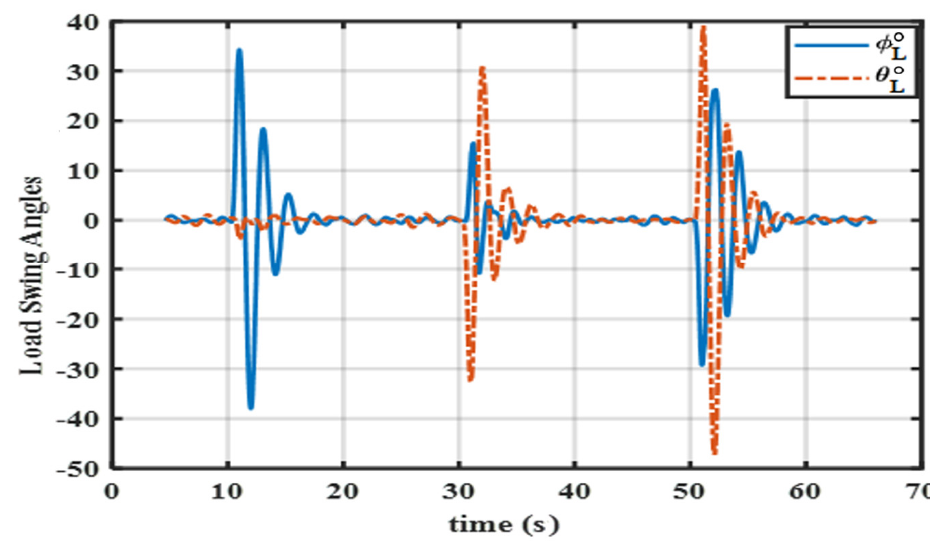
Figure 21. Time history of the load swing angle during travel maneuver with the ASC.